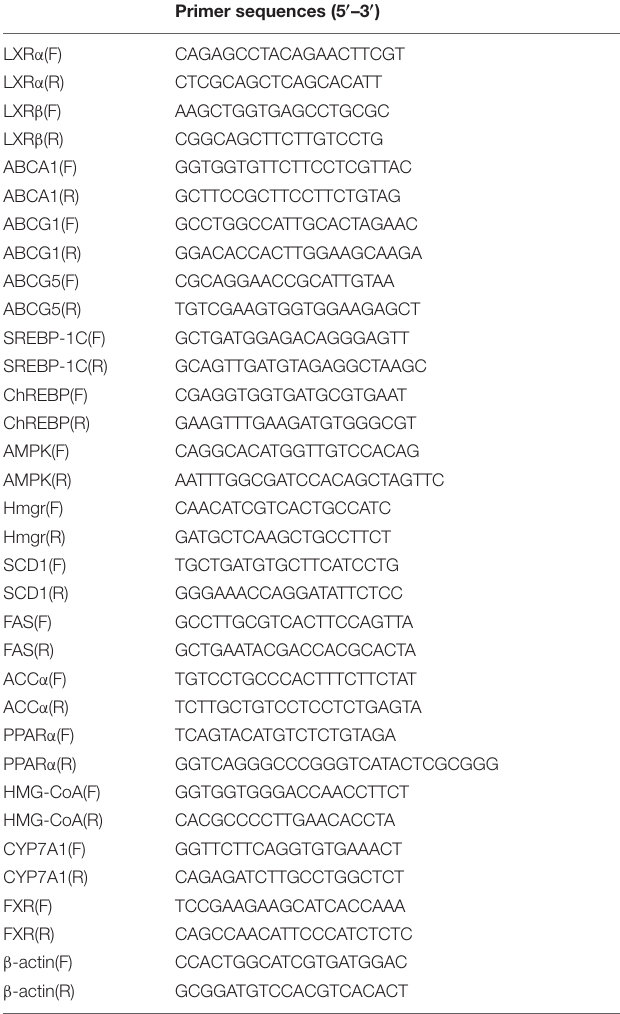
TABLE 2 | List of genes measured in liver and small intestine tissues isolated from rats. Primer sequences (5 (cid:48) –3 (cid:48) )